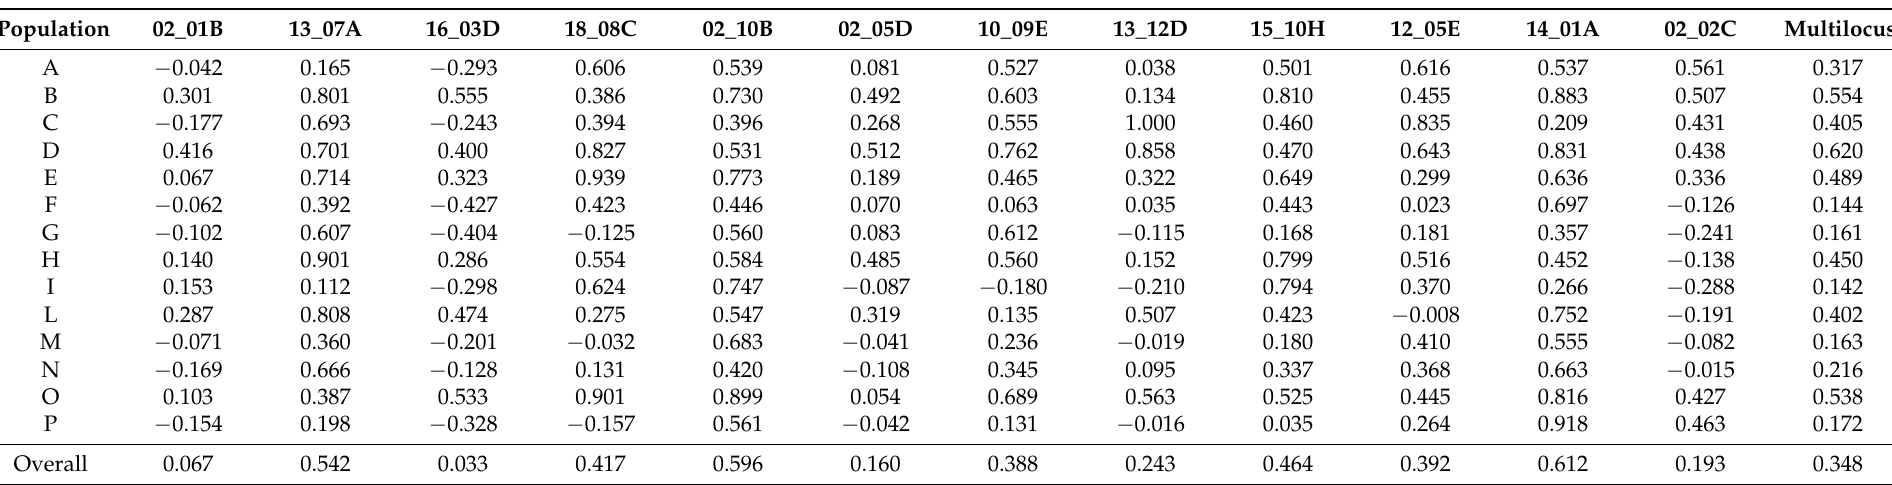
Table 6. Inbreeding coefficient G IS in pairwise comparisons among the 12 SSR loci and the 14 varieties under study. G IS values at the multilocus level are also